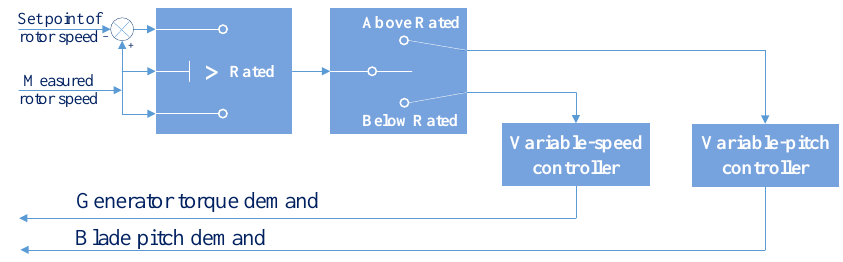
Figure 3. VSVP control loops of modern wind turbine.